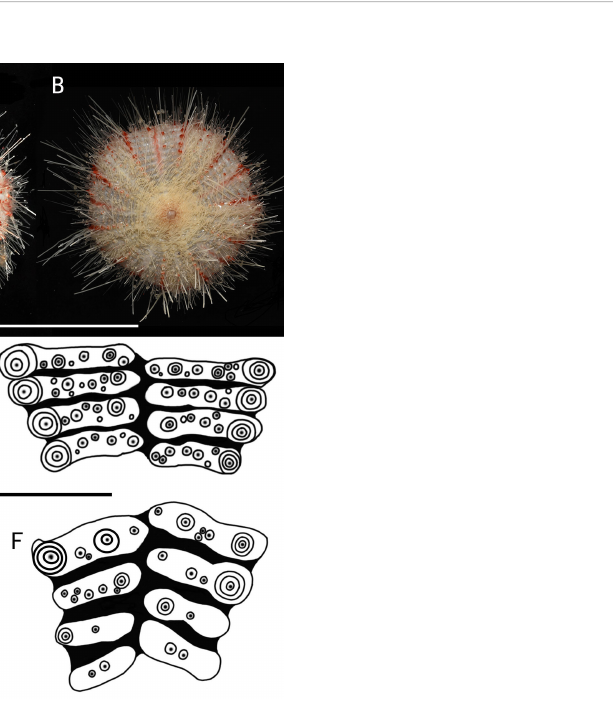
FIGURE 7 Araeosoma polyporum sp. nov.; holotype, MBM286949 (test diameter, 46.4 mm). (A) Aboral view. (B) Oral view. (C – F) Details of the coronal plates: (C) , oral ambulacra (D) , oral interambulacral (E) , aboral ambulacra (F) aboral interambulacral. Scale bars , 50 mm (A, B) and 10 mm (C – F)